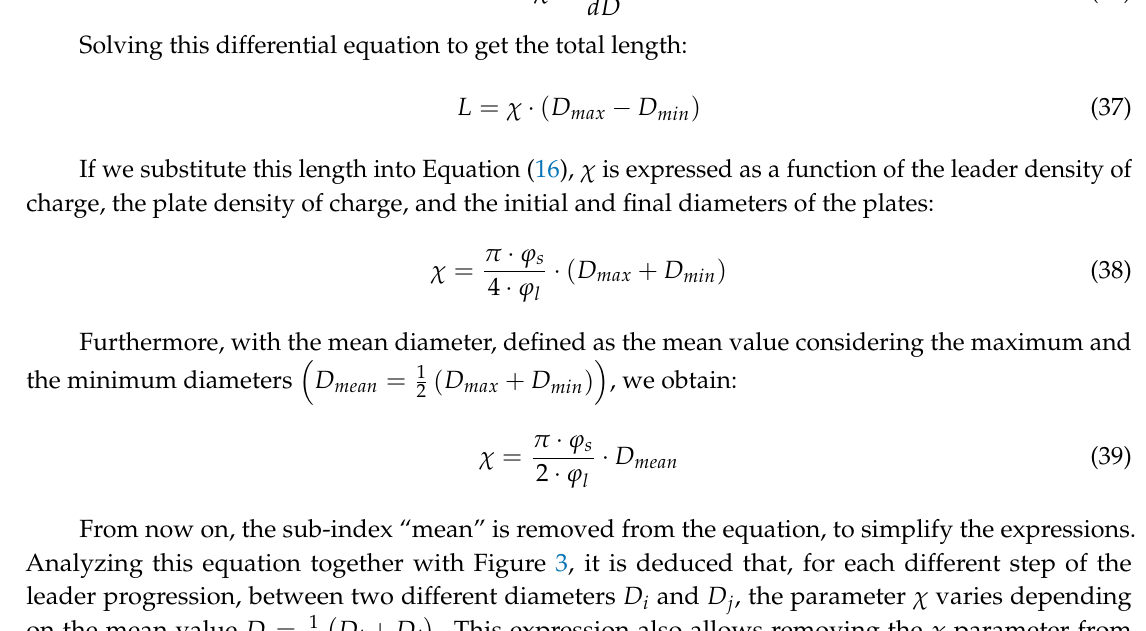
Solid lines correspond to Lorenz D